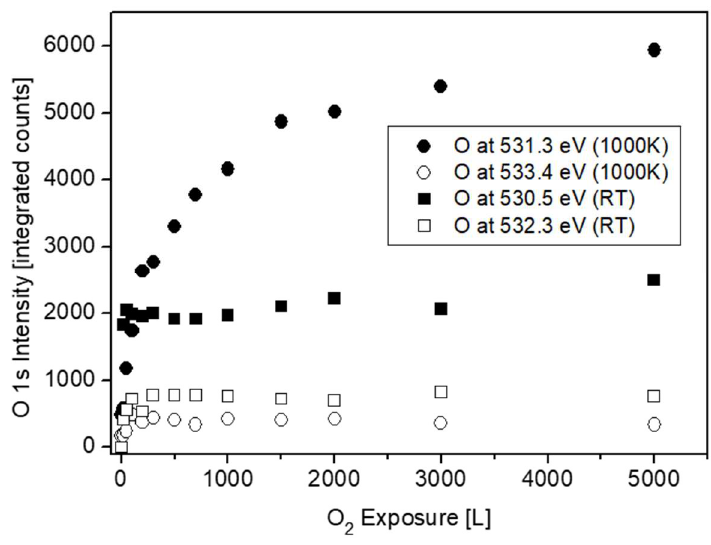
Figure 14. O 1s intensity vs. oxygen exposure at RT and 1000 K.